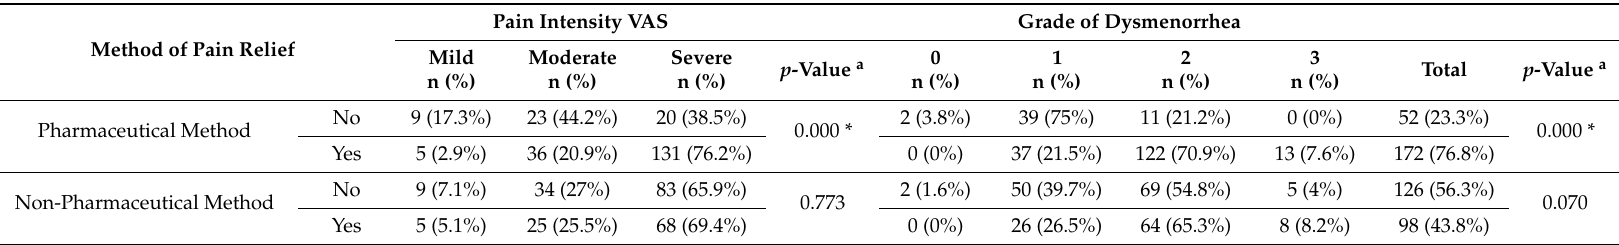
Table 2. Method of pain relief chosen by women with dysmenorrhea according to pain intensity (VAS) and grade of dysmenorrhea (Andersch and Milsom scale). Method of Pain Relief